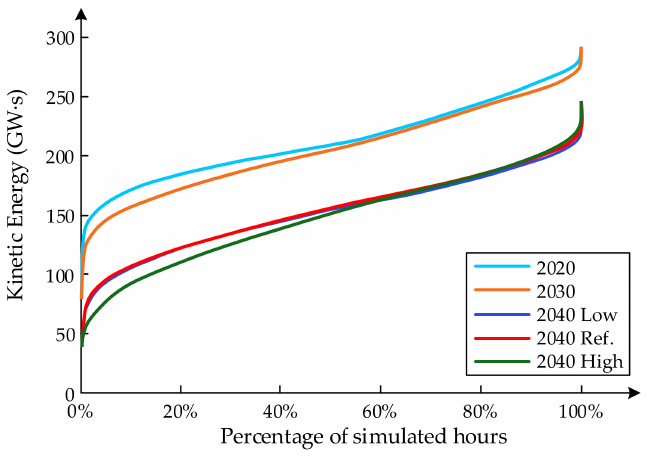
Figure 8. System inertia in the NPS for the period 2020–2040 [5].